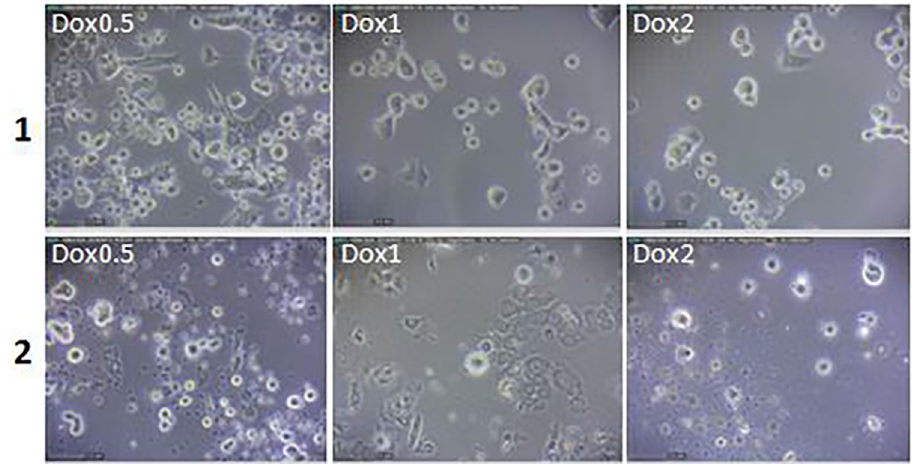
Fig 7. The effects of different concentrations (0.5, 1 and 2 μ g) of the doxorubicin (Dox) on morphology of the MCF7 (row 1) and HUVEC cell lines (row 2).